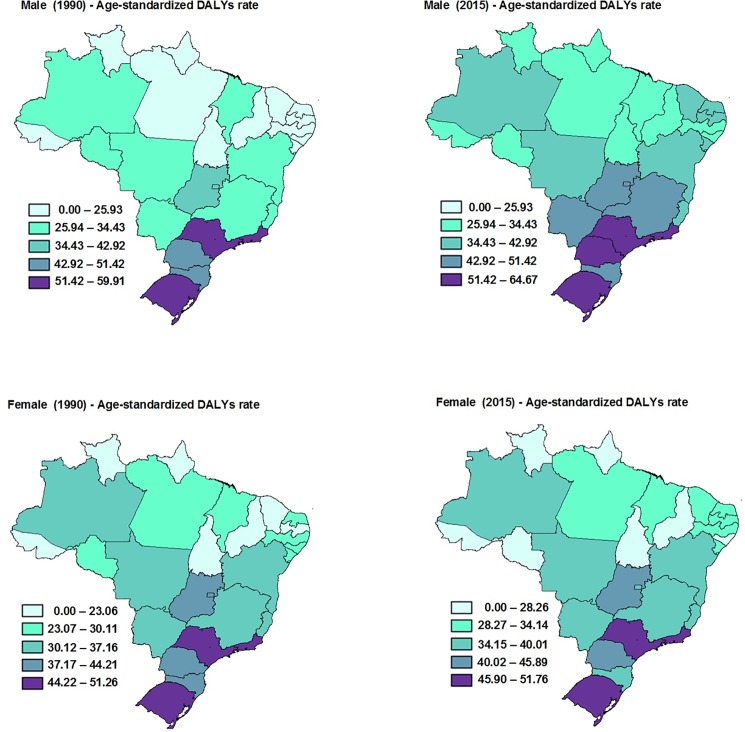
Age-standardized DALYs (per 100,000 inhabitants) from colorectal cancer due to physical inactivity in males and females in the Brazilian states.